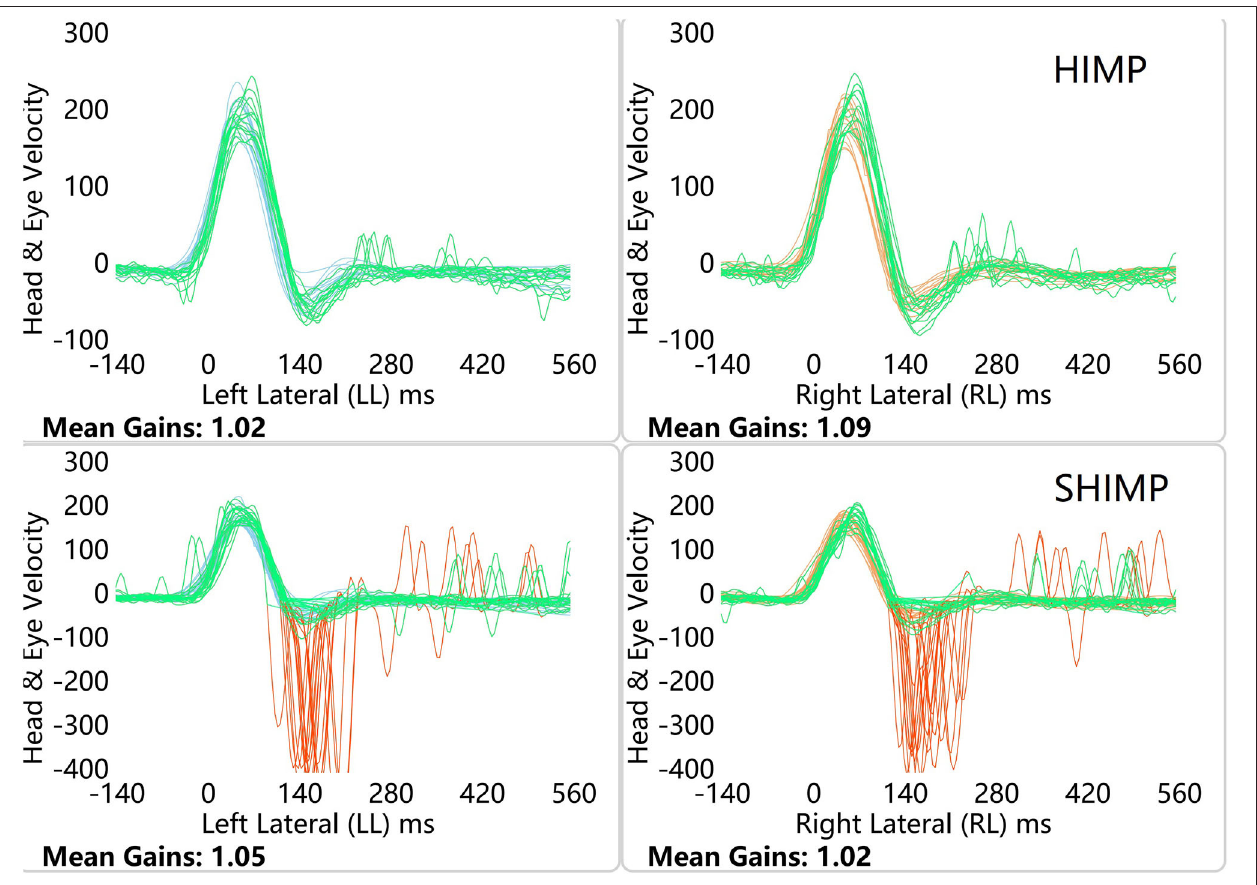
FIGURE 1 | HIMP and SHIMP graphs in a healthy participants. The image above is bilateral HIMP and the image below is SHIMP of healthy participants. In healthy participants, a small number of weak saccades in the left and right sides were observed in the HIMP, while multiple anti-compensatory saccades were detected in the